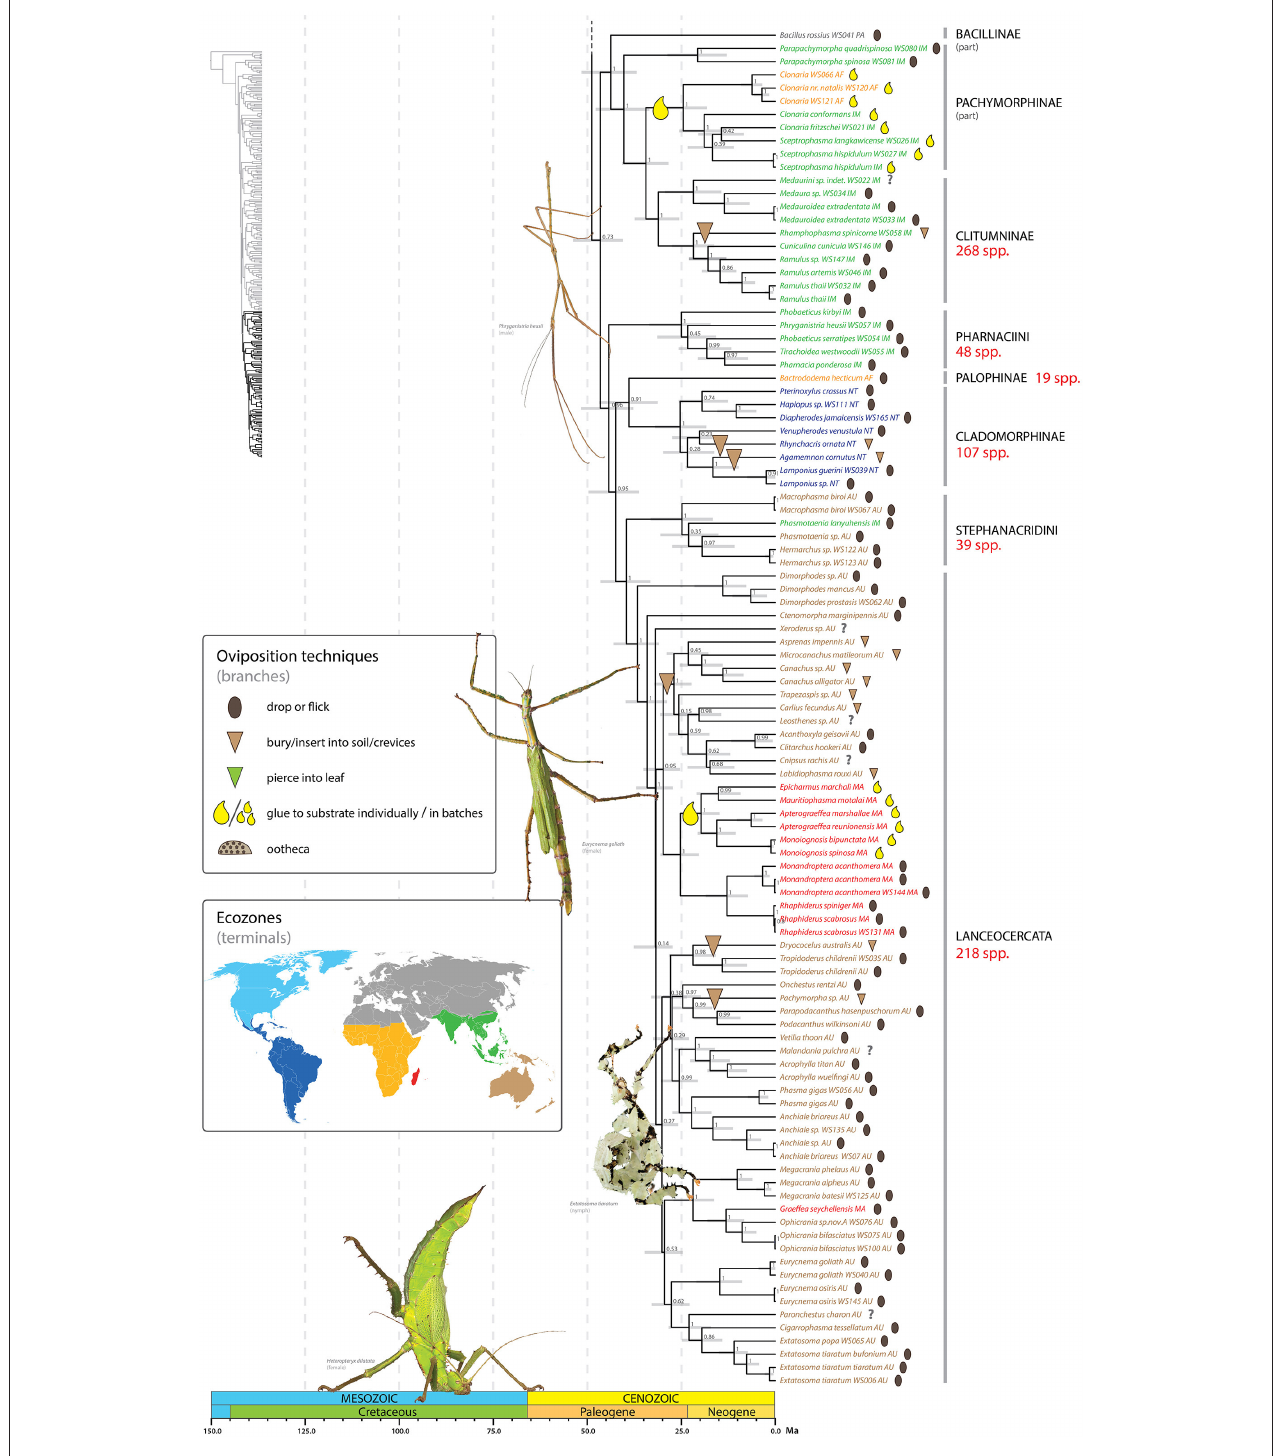
FIGURE 6 | Chronogram of Phasmatodea (part 3 of 3). The full time tree is shown to the left with the emboldened region enlarged and colored for discussion. See Figure 1 caption for details. Photos of stick and leaf insects by Finalion ( Eurycnema goliath ), Laetitia Bourgois ( Extatosoma tiaratum ), Magnus Forsberg ( Heteropteryx dilatata ), Bruno Kneubühler ( Phryganistria heusii ) modified for use, used by permission.